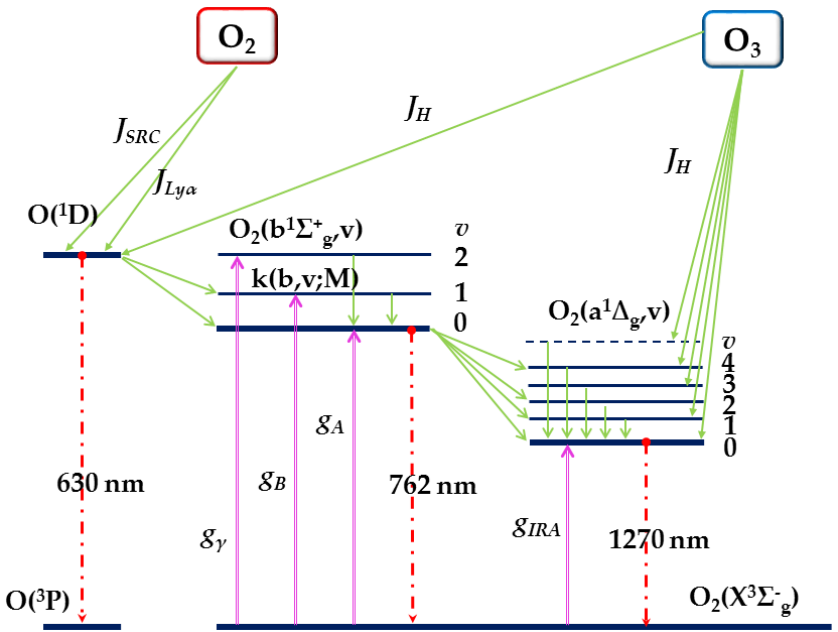
Figure 2. Dayglow production mechanism of the O 2 infrared atmospheric band [20].